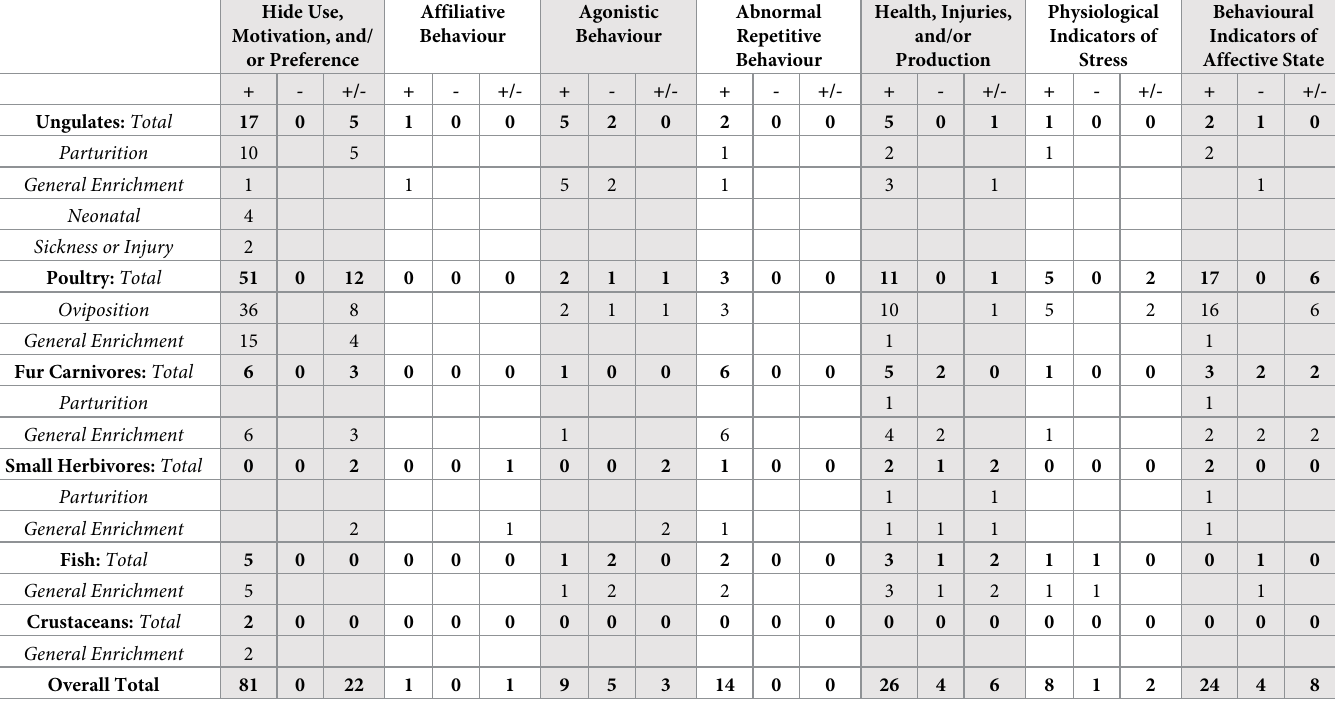
Table 2. Categorization of 151 papers based on how provision of a hiding space impacted the animals. The number of outcomes per context of hide provision is listed under each animal category. Missing categories indicates that there were no outcomes found in that context for that species; a blank cell indicates that no outcomes were found for that animal category and context of hide